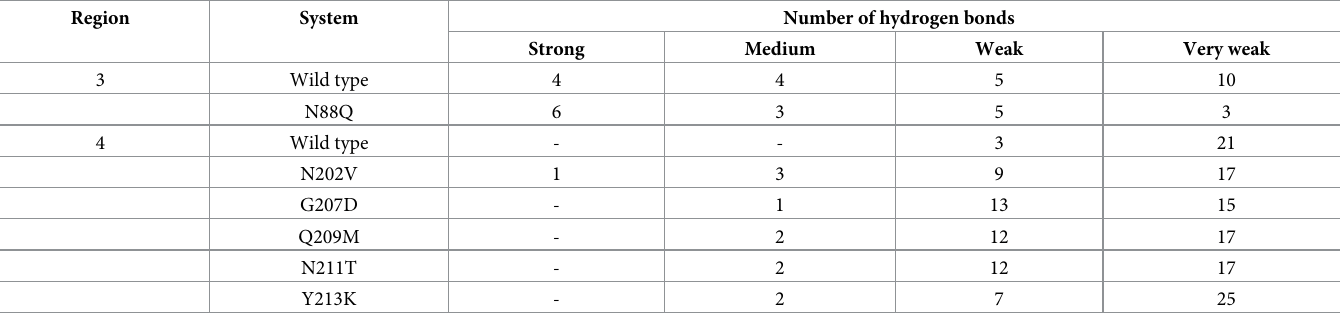
Table 5. Number and strength of hydrogen bonds at 313 K of all residues in the highly flexible regions and their neighboring residues.